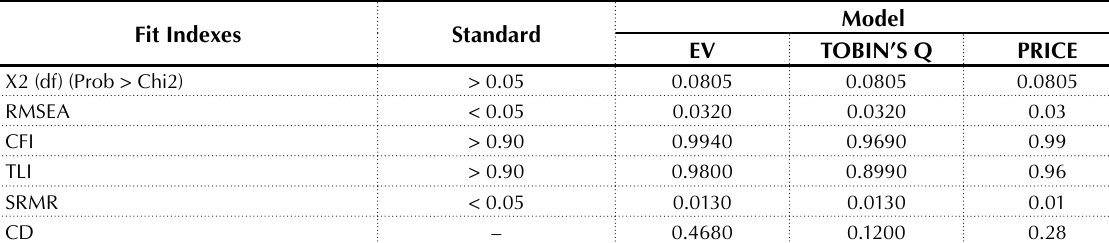
Table 8. Results of statistical test for model